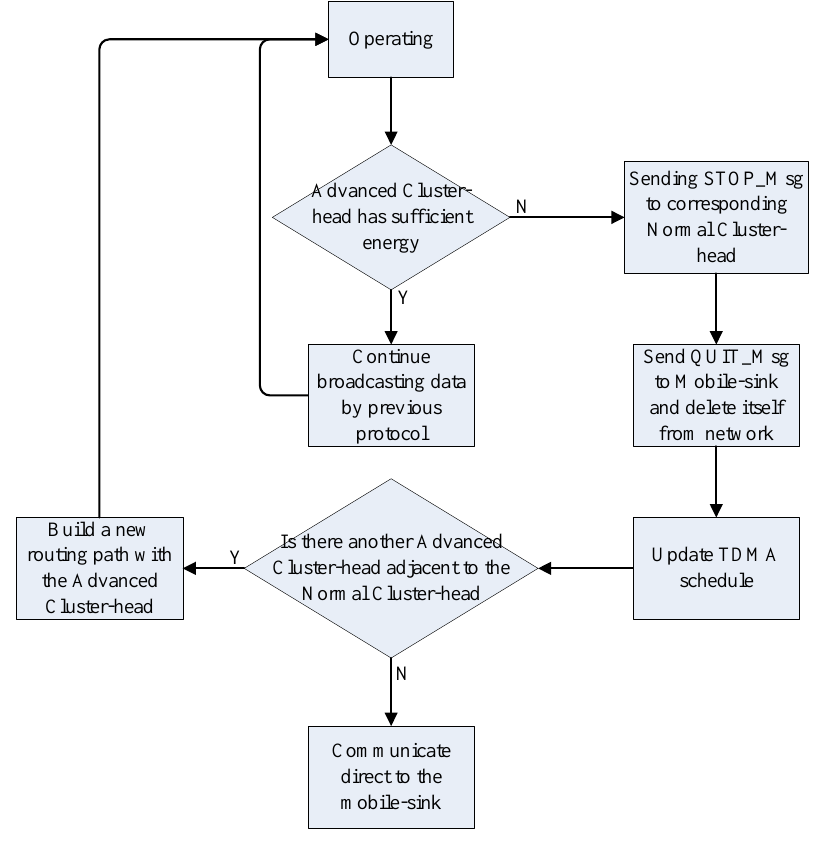
Figure 7. Flowchart for our maintenance method.